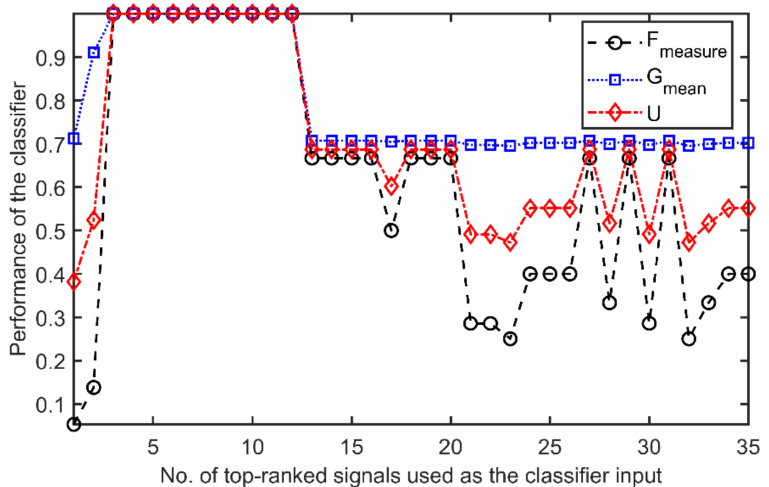
Figure 6. Performances, on the test set, of the CS-SVM classifiers built with different subsets of the Relief top-ranked